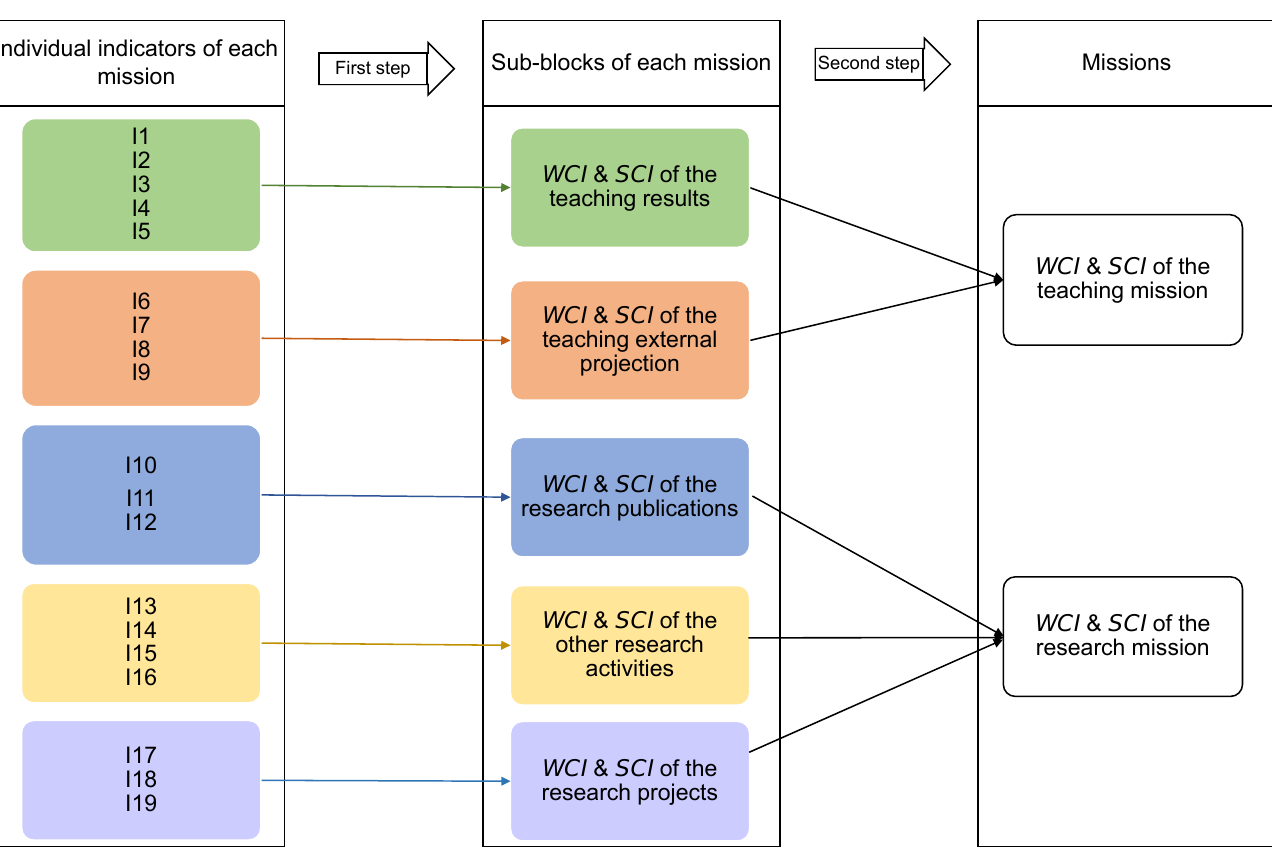
Figure 2. Steps for constructing the WCI and SCI by universities for each academic